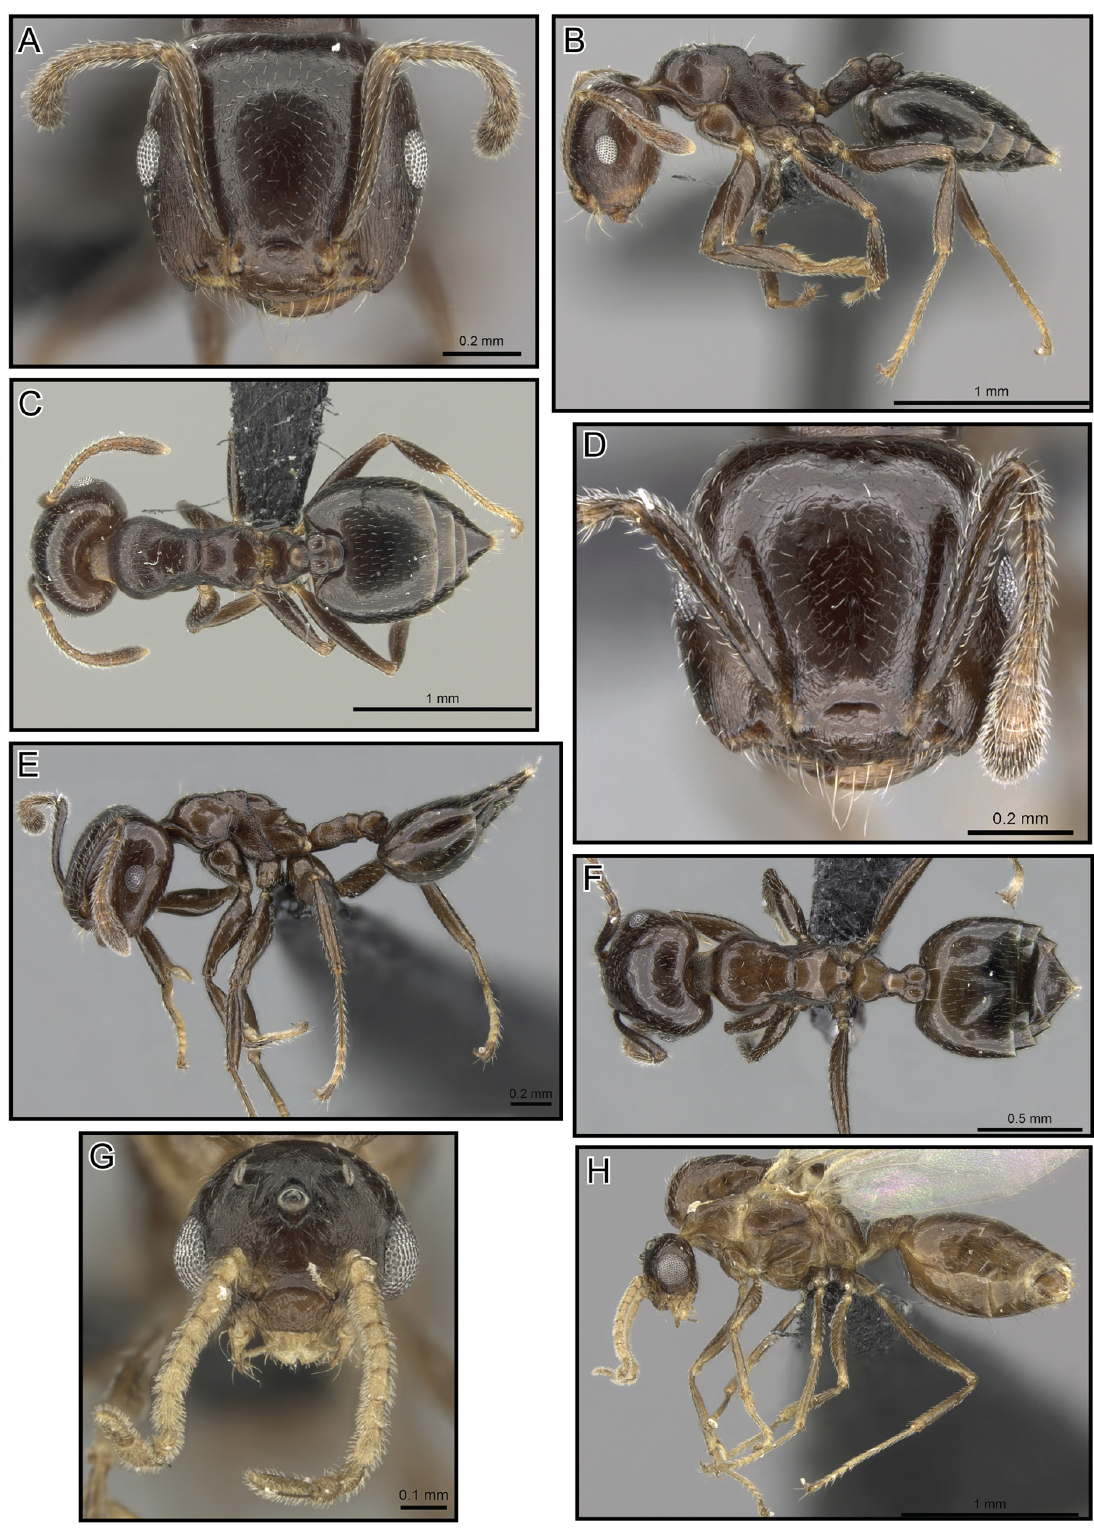
Fig. 10. Crematogaster dentata Dalla Torre, 1893 stat. nov., workers and male. A-C. Worker (CASENT0456641). A. Full-face. B. Profile. C. Dorsal. D-F. Worker (CASENT0138289). D. Full-face E. Profile F. Dorsal. G-H. Male (CASENT0456644). G. Full-face. H.